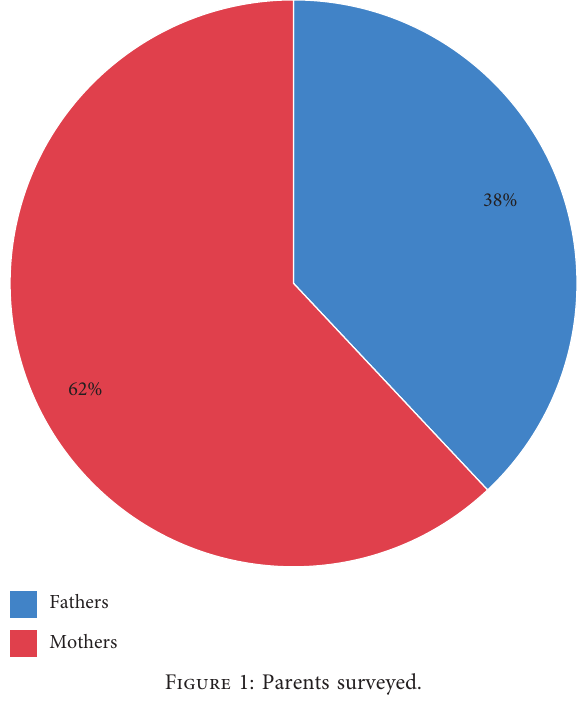
Figure 1: Parents surveyed.